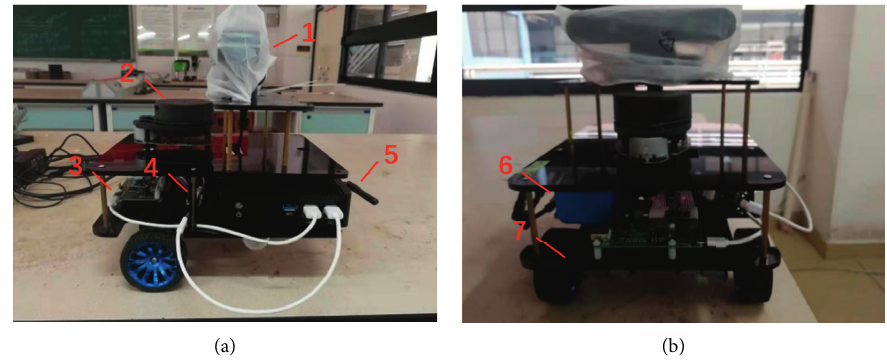
Figure 2: Key modules of the robot. (1) “RGB-D,” used to get RGB image and depth image; (2) “lidar,” used to get 2D lidar point cloud; (3) “STM32 controller,” used to control the movement of the car; (4) “gyroscope,” used to get the attitude information; (5) “WI-FI,” used to contact with the host computer; (6) “power supply system”; and (7) “motor and encoder,” used to get the velocity feedback of the car